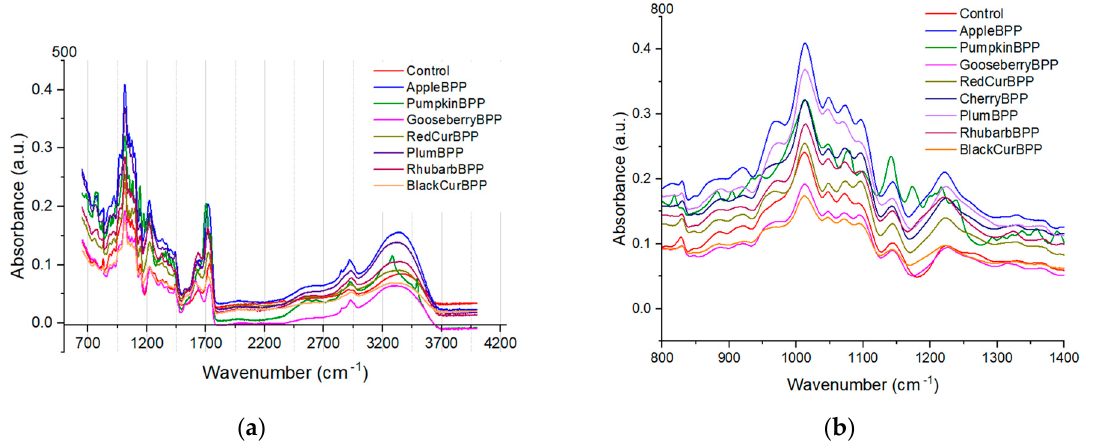
Figure 2. FT-IR spectra of the pectin from by-products and control sample from Sigma Aldrich Pectin; ( a ) FT-IR in the region 700–3700 cm − 1 ; ( b ) FT-IR in the region 900–1400 cm − 1